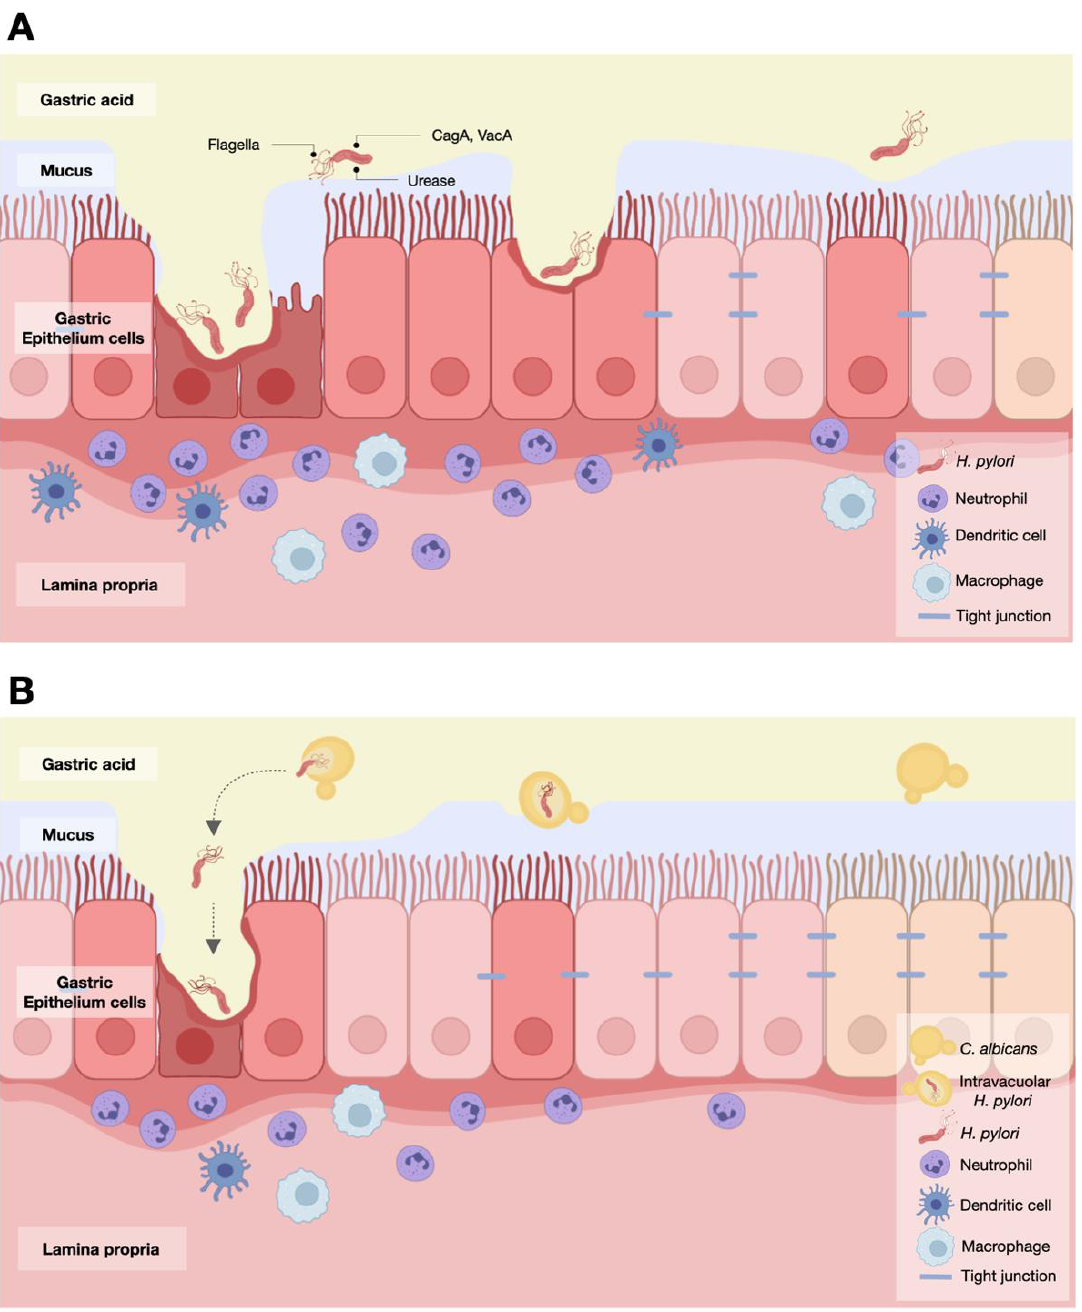
Figure 8. The proposed working hypothesis demonstrates the role of H. pylori with and without Candida in gastritis. Without Candida , H. pylori activate immune cells and enhance gastric inflammation ( A ). With Candida , the intravacuolar H. pylori are released from the yeast cells and induce gastric inflammation ( B ). This picture was created by BioRender (https://app.biorender.com/, accessed on 5 March 2022).